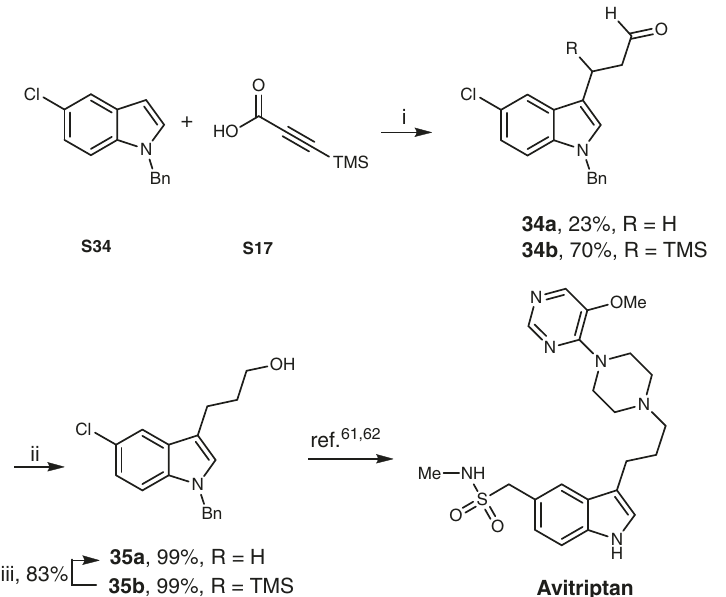
Fig. 2 Synthesis of intermediate 35a for Avitriptan. i: [Rh(CO) 2 acac]/ L1 /CSA/ S17 / S34 = 1:6:6:150:100, 0.5mmol scale of S34 , CO/H 2 (1:1, 30bar), DCE (3mL), 50°C, 20h. ii: NaBH 4 (2 equiv.), MeOH, 0°C, 30min. iii: KO t Bu (10mol%), 18-crown-6 (10mol%), DMSO:H 2 O (19:1, v/v), 80°C, 5h. TMS =